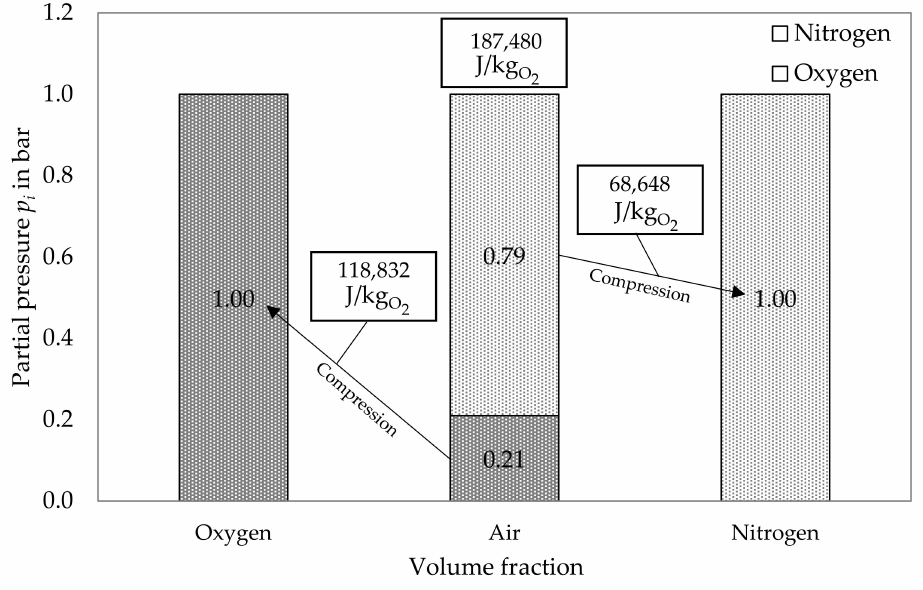
Figure 1. Reversible isothermal partial compression for air separation: energy